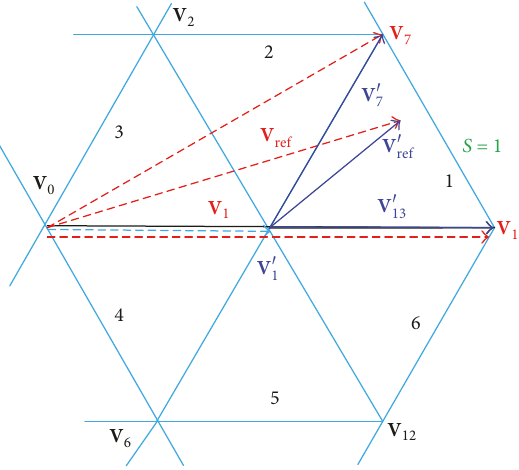
Figure 4: Vector translation of reference voltage under 𝑆 = 1